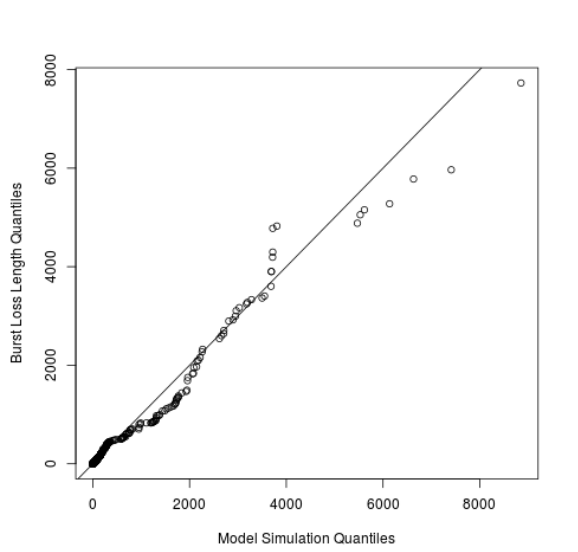
Figure 9. QQ-Plot of BLL of validation data set and simulation.